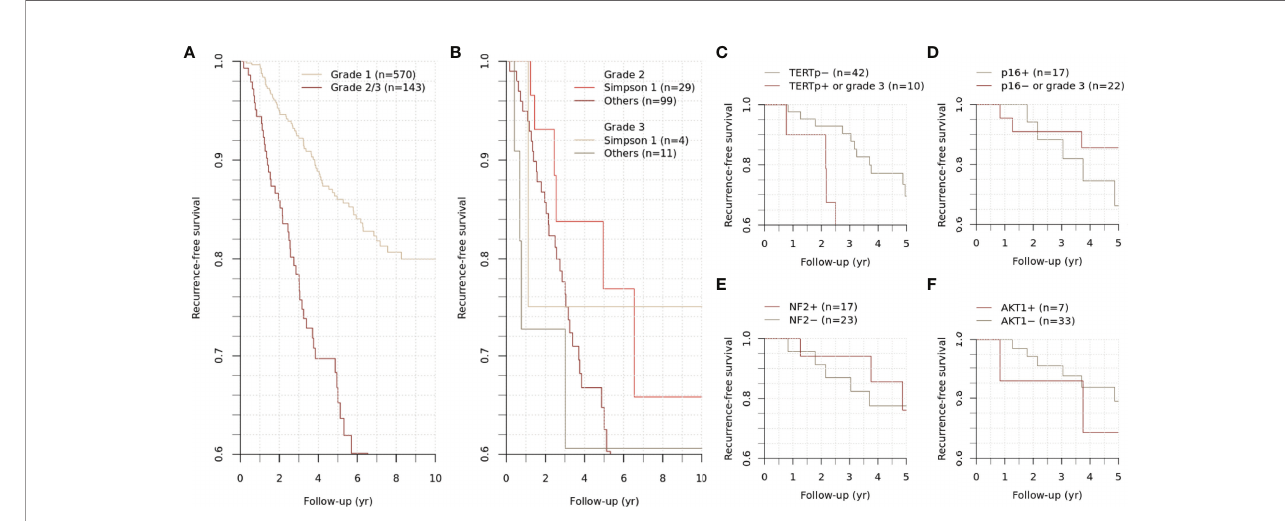
FIGURE 2 | Recurrence-free survival of grade 2/3 meningiomas. Differential recurrence-free survival was observed between grade 1 and grade 2/3 meningiomas (A) . The survival difference between grades 2 and 3 was insigni fi cant (B) . The subgroups of grade 2/3 meningiomas were strati fi ed according to the mutational status of speci fi c genes (C – F) .